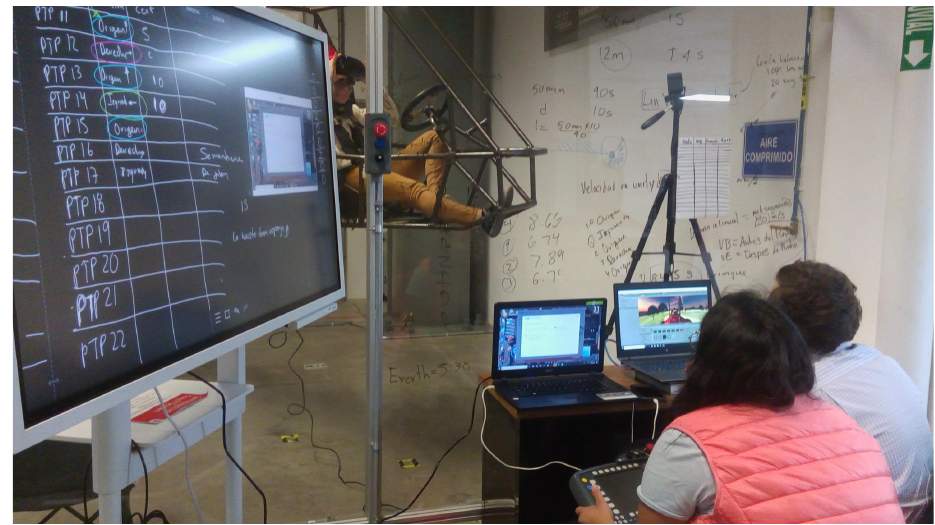
Figure 7. Immersive virtual experience in automotive projects at the VR/AR laboratory at UPAEP